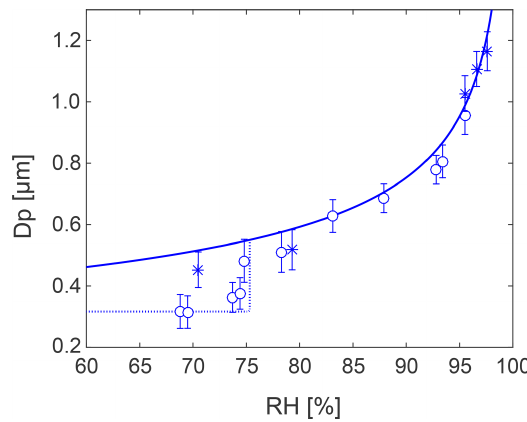
Figure 10. Hygroscopic growth of deliquesced (asterisk) and un- deliquesced (open circles) NaCl particles with D p , dry = 320nm at T = 20 ◦ C with welas 2300. As reference the theoretical Köhler curve for deliquesced particles (solid line) as well as the deliques- cence point (dashed line, deliquescence at 75.7% measured at 25 ◦ C by Tang et al., 1977) are shown. We observe deliquescence of NaCl particles at about